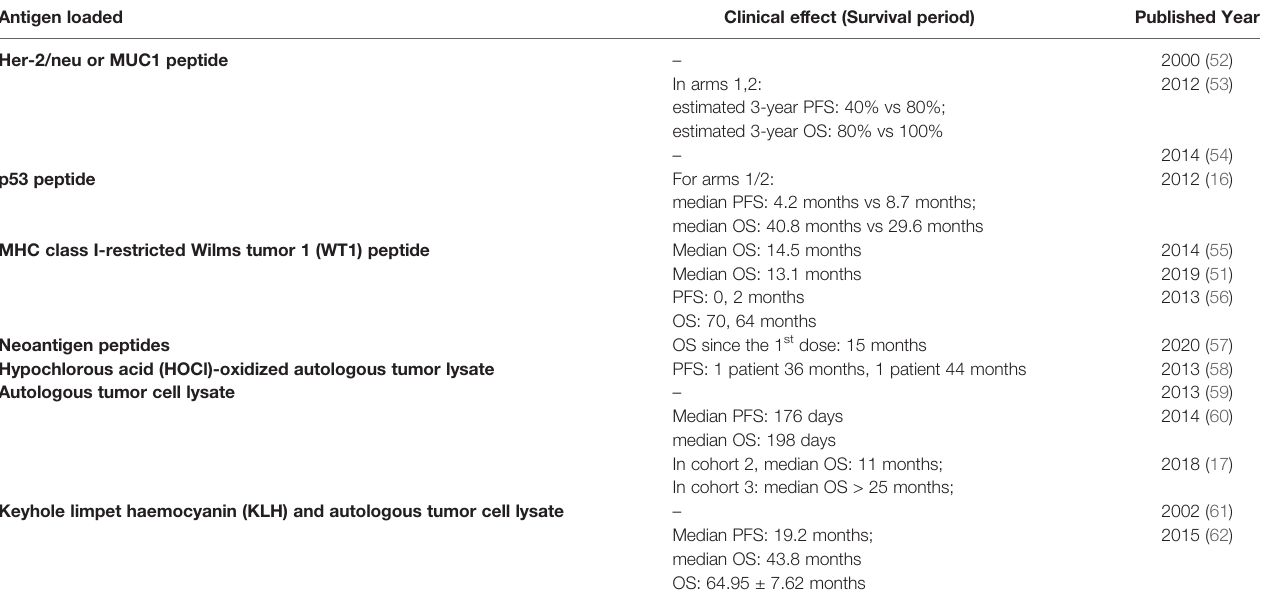
TABLE 1 | The antigen of dendritic cell (DC) vaccines used in the clinicial trials in ovarian cancer. Antigen loaded Clinical effect (Survival